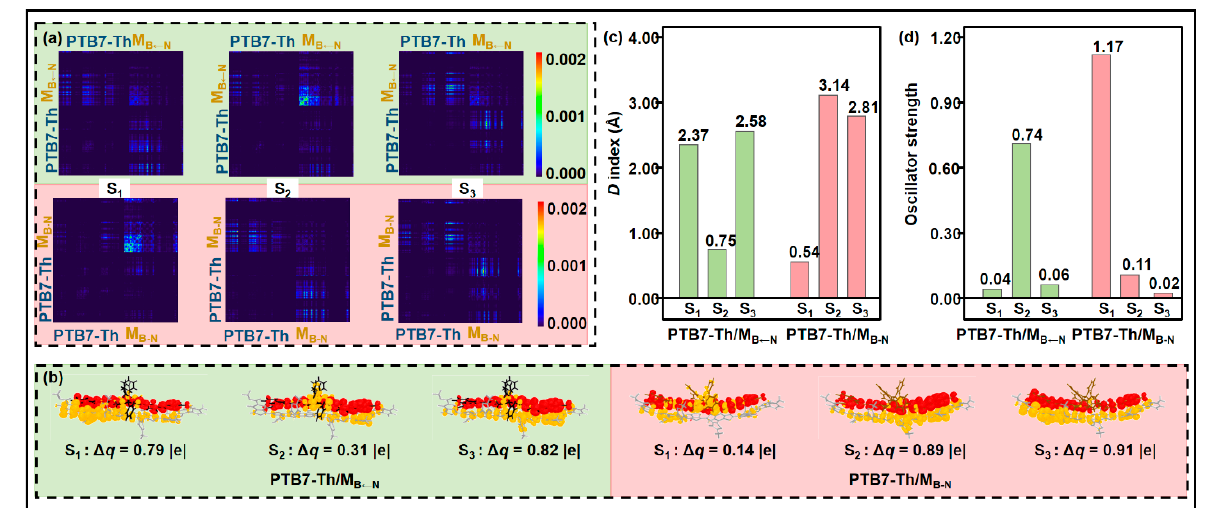
Figure 4. ( a ) 2D site representation of the transition density matrix (TDM), ( b ) charge difference density (CDD) maps with net transferred charge ( Δ q ), ( c ) D index, and ( d ) oscillator strengths of the lowest three excited states (S 1 -S 3 ) of the studied interfaces (CDD: red/yellow stands for accumulation/depletion of negative charges).